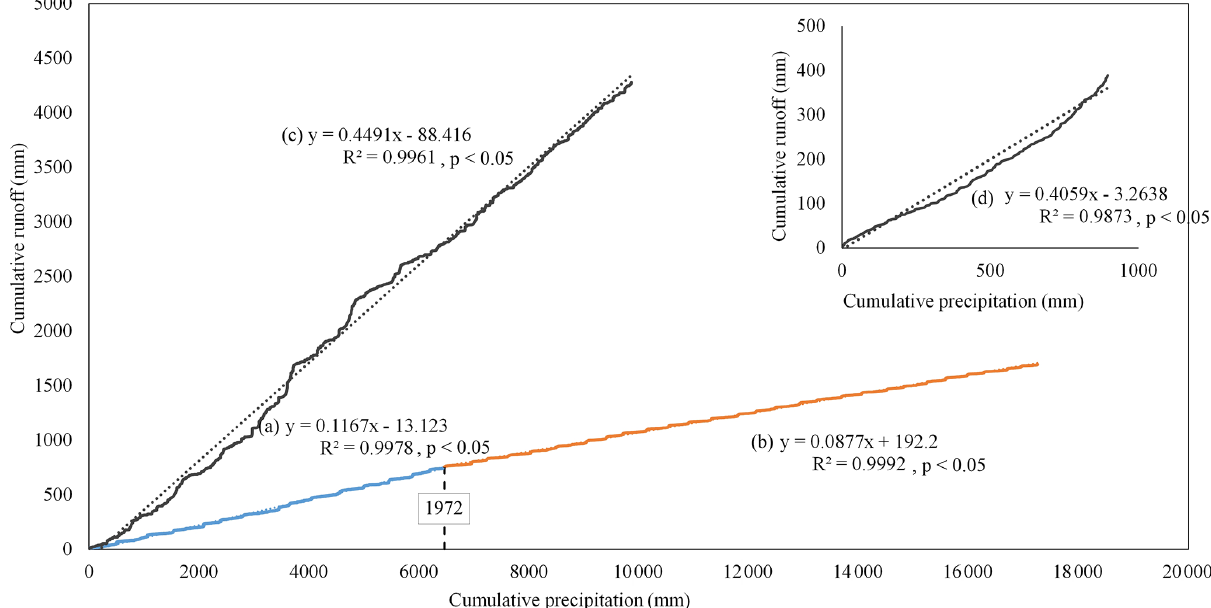
Figure 11. Double mass curves between daily runoff and precipitation for (a) Wuding River basin from 1958–1972; (b) Wuding River basin from 1973–2000; (c) Xun River basin from 1991–2001. Subgraph (d) represents the double mass curve between the mean daily runoff and precipitation from